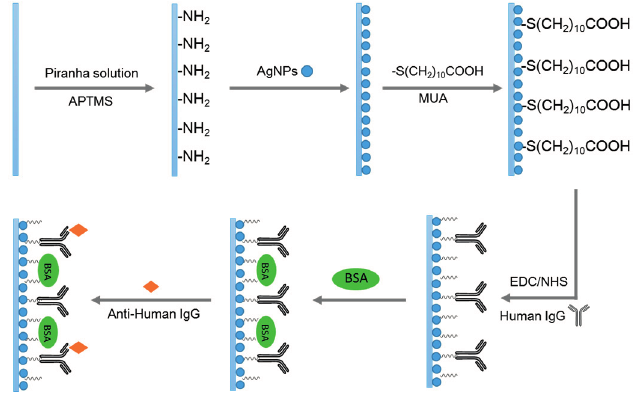
Figure 1. Schematic of bio-sensing approaches using the Ag NPs-based LSPR sensor probe developed in this